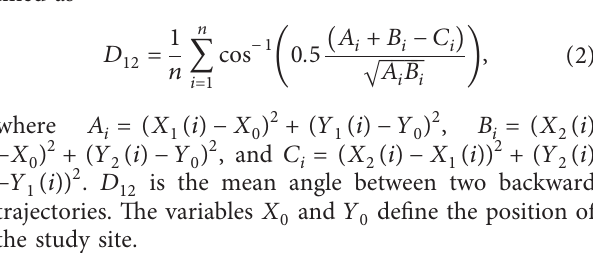
Figure 1: Topography of China (a), locations of the seven polluted cities (b), and the geographical distribution of PM in this study